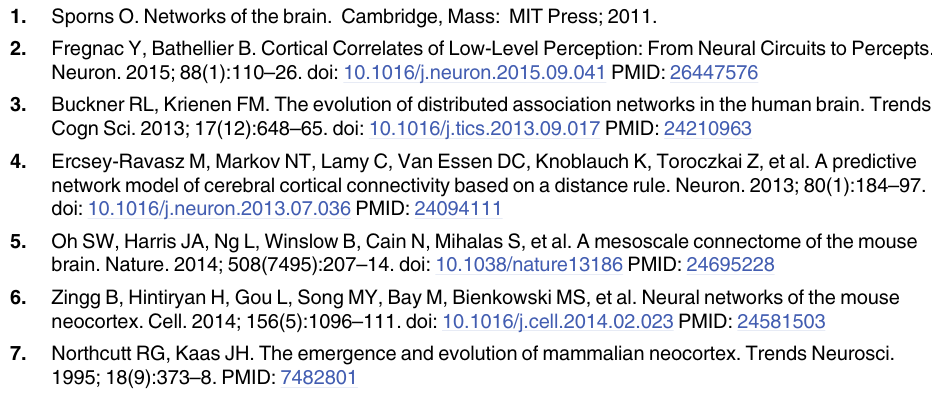
network realizations (200 realizations). The mouse tracing data (panels c and d ) is dominated by anterograde tracing, in which case the in-degrees are the population sample data (panel c ), whereas the out-links show variability between the individual animals (panel d ). The red marks and the black are for the corresponding EDR model (with the same description for col- ors as for the macaque) in the mouse with λ mus = 0.78 mm − 1 (200 realizations). S5 Fig. Motif distributions compared to the EDR model as a null-model. Bars show ln m data where m denotes the count of each possible three-motif in the empirical connectome and its corresponding EDR model, respectively. Counts from the models are averaged over 1,000 trials, black lines represent 95% con fi dence intervals. S6 Fig. Wire length minimization. The vertical line shows the total wire length in the empiri- cal network ( data ). The histogram is constructed from the total wire lengths in a set of net- works obtained by randomly permuting the areas of the empirical network ( rand ). S7 Fig. Permutation test of Macaque/Mouse distance variance ratio. Macaque and mouse have significantly different distributions. Black line, empirical data; number of permutations: